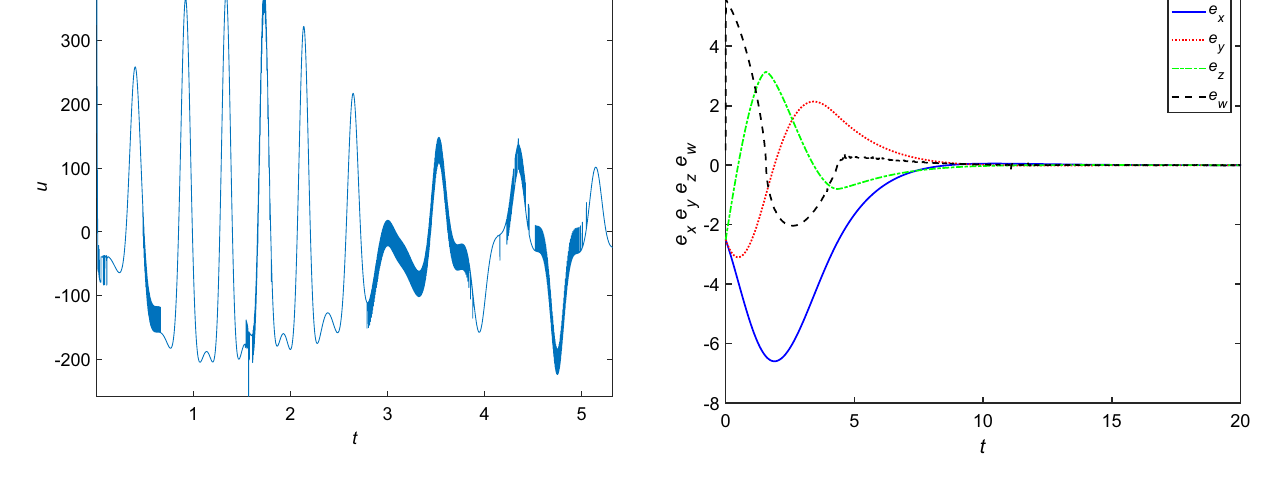
Fig. 6 The enlargement of control u